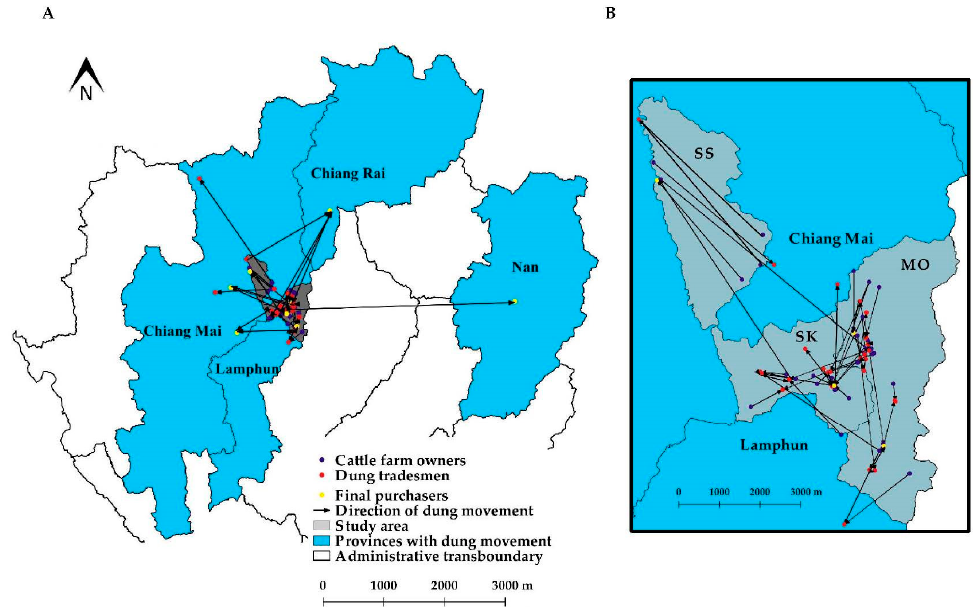
Figure 2. Map of Northern Thailand depicting spatial distribution of manure movements in the network ( A ) and the magnified map focusing manure movements on the study area including Mae On (MO), San Kamphaeng (SK), and San Sai (SS) ( B ). Table 3. Frequency of trading, distance from tradesman origin to cattle farm and to final purchaser. Frequency of Trading (Time/Month) and Frequency of Trading (Time/Month) and District Distance from Tradesman Origin to Cattle Distance from Tradesman Origin to Final Farm (Kilometers) Purchaser (Kilometers) Mean ± sd Mean ± sd Min . Max . Mean ± sd Mean ± sd Min.